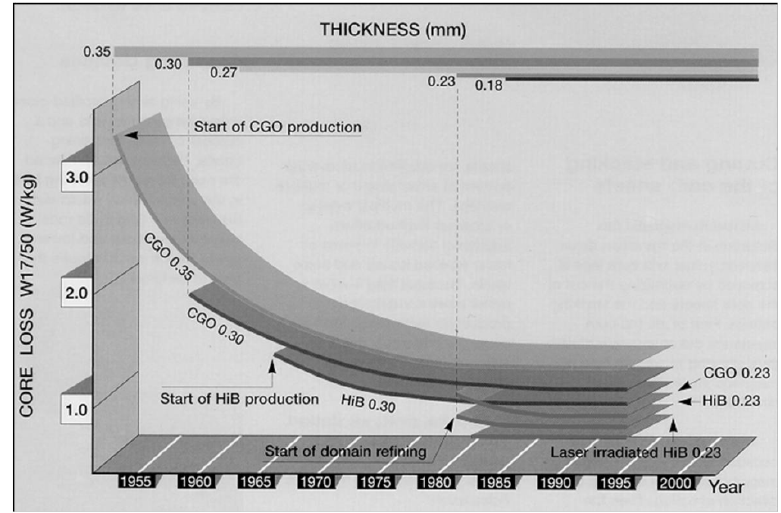
Figure 3. “Core loss evolution”. Source: De Keulenaer